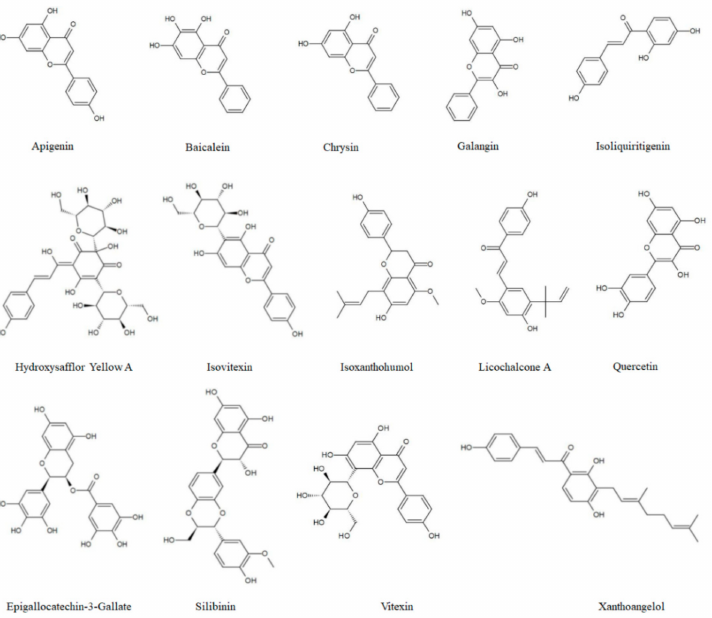
Figure 1. The chemical structure of several flavonoids that target